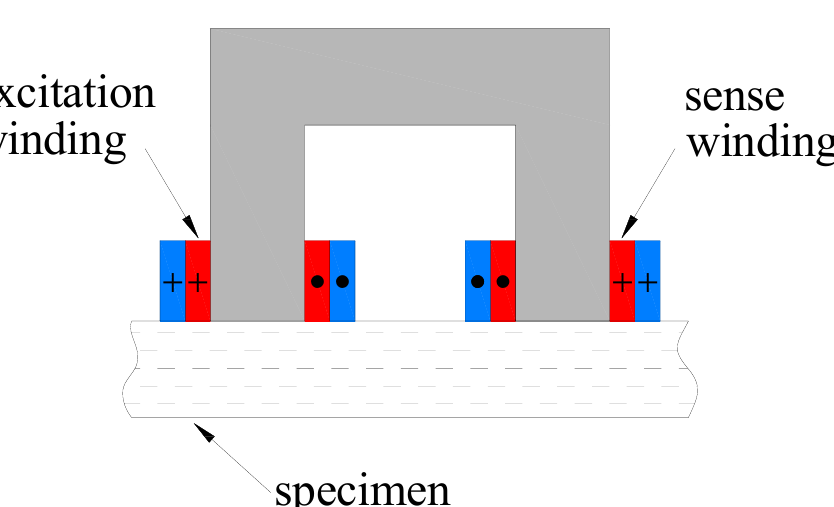
Figure 3. Two winding probe.